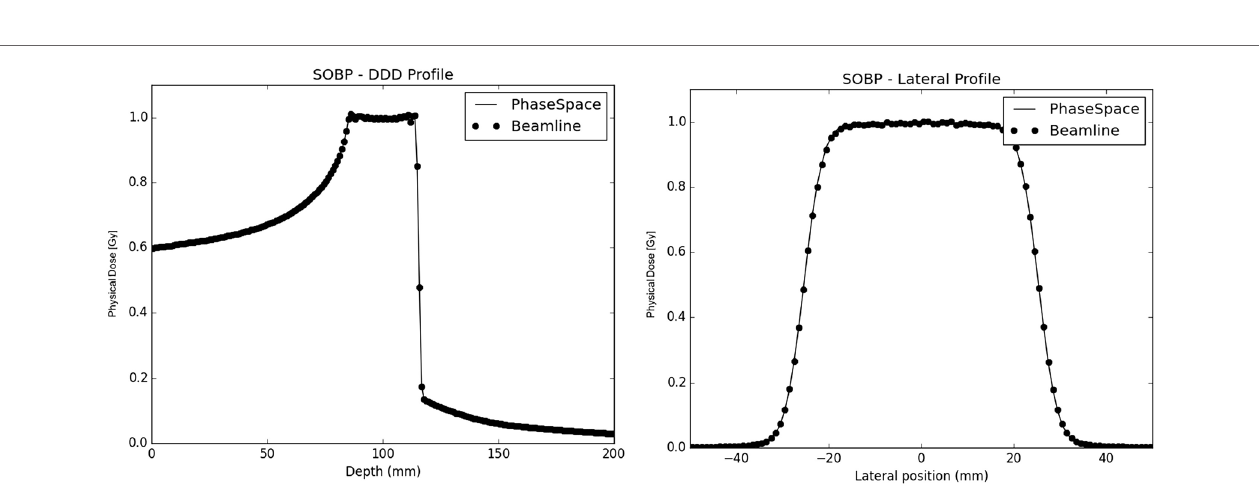
FigUre 7 | sOBP Profiles in water: on the left panel, the depth dose profiles of both the Ps (full line) and the beamline (dot line) approaches are plotted together; on the right panel the lateral dose profiles at the center of the sOBP for both the Ps (full line) and the Bl (dot line) approaches are